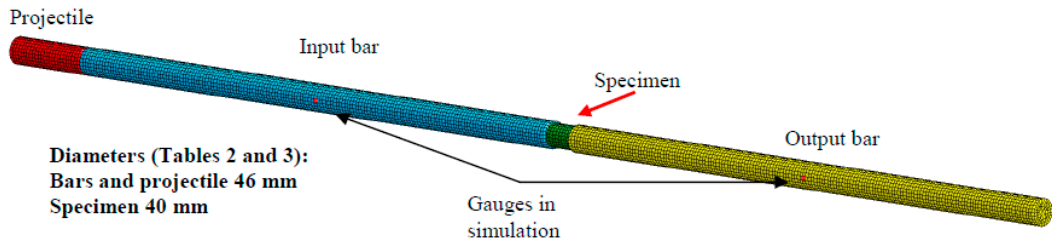
Figure 7. Discretization of the finite element model to simulate dynamic compression of concrete.